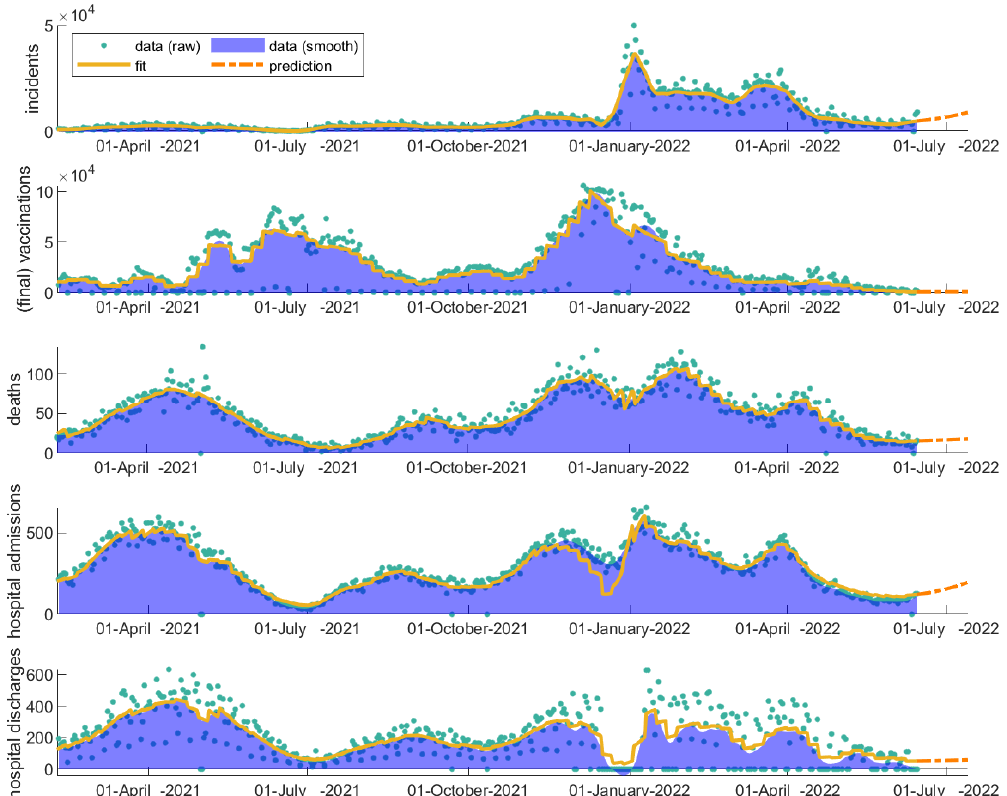
Figure 7. Real and fitted data for Greece from daily incidents, vaccinations, deaths, admission to and discharges from the hospitals for the fitting time period 1 February 2021–15 June 2022. The real data are shown with blue dots. The model fitting is shown with a continuous line and the future two-week predictions are shown with a dashed line.